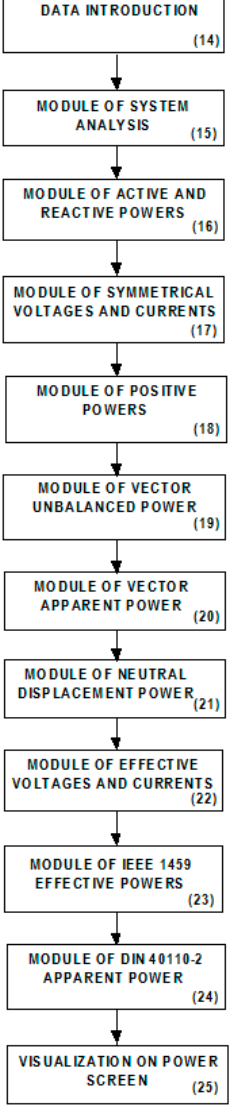
Figure 6. Power programming module.